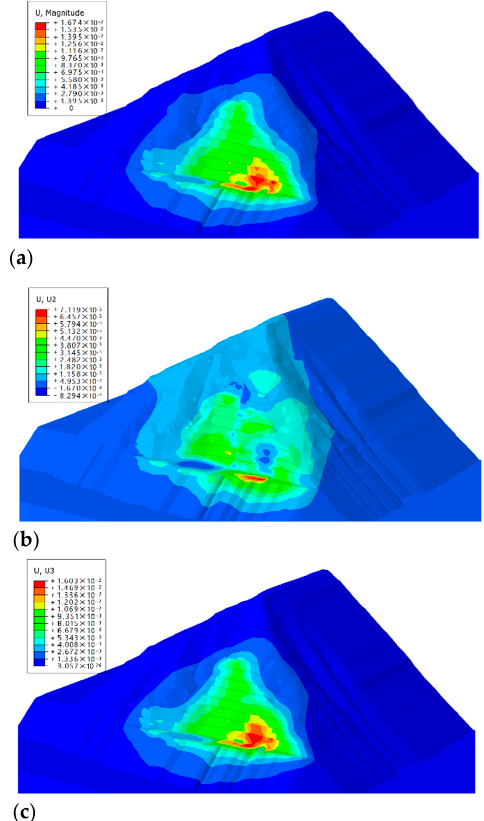
Figure 12. Displacement distribution after excavation. ( a ) Resultant displacement. ( b ) Displacement along slope direction. ( c ) Vertical displacement.